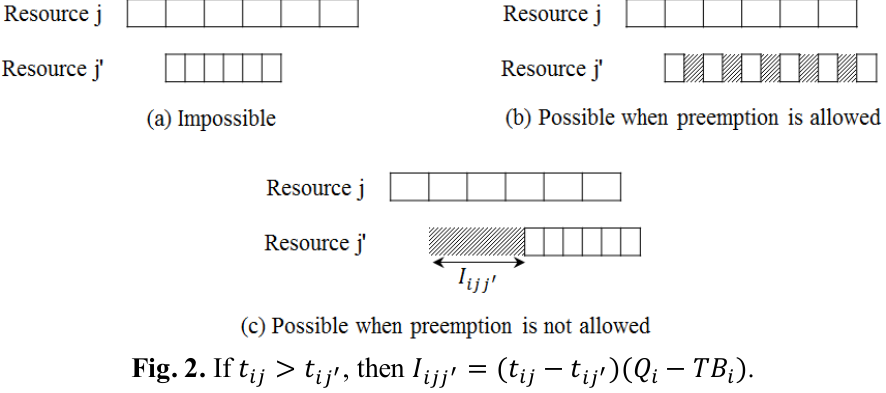
(cid:3036)(cid:3037)(cid:3037) (cid:4594)